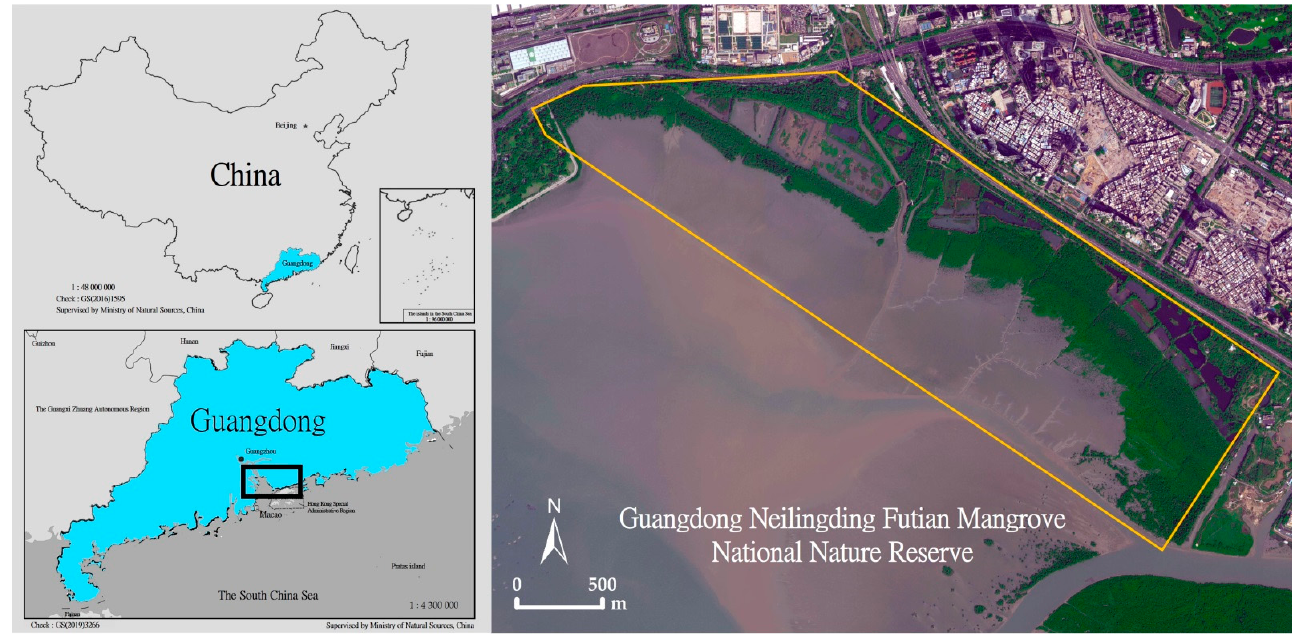
Figure 1. A map of Guangdong Neilingding Futian Mangrove National Nature Reserve, Shenzhen Bay, China (sampling location).